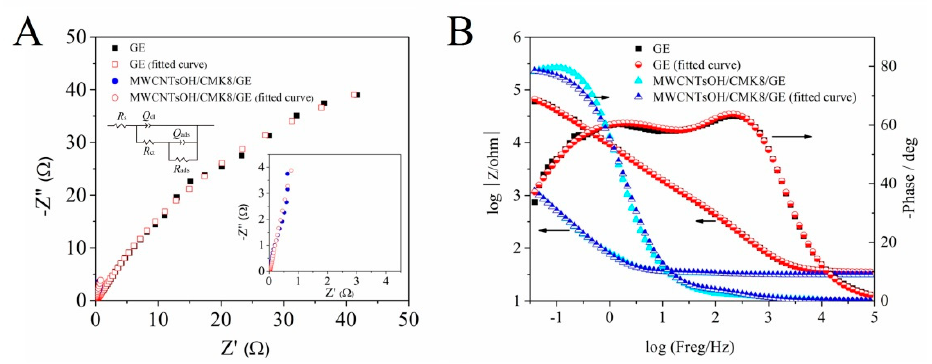
Figure 3. ( A ) Nyquist and ( B ) Bode diagrams of GE and MWCNTs − OH / CMK − 8 modified electrode in 1.0 µ mol / L OLA. The inset is the Equivalent circuits. Table 1. Equivalent circuit parameters of OLA electro-reduction on differently modified electrodes obtained from Figure 3B.